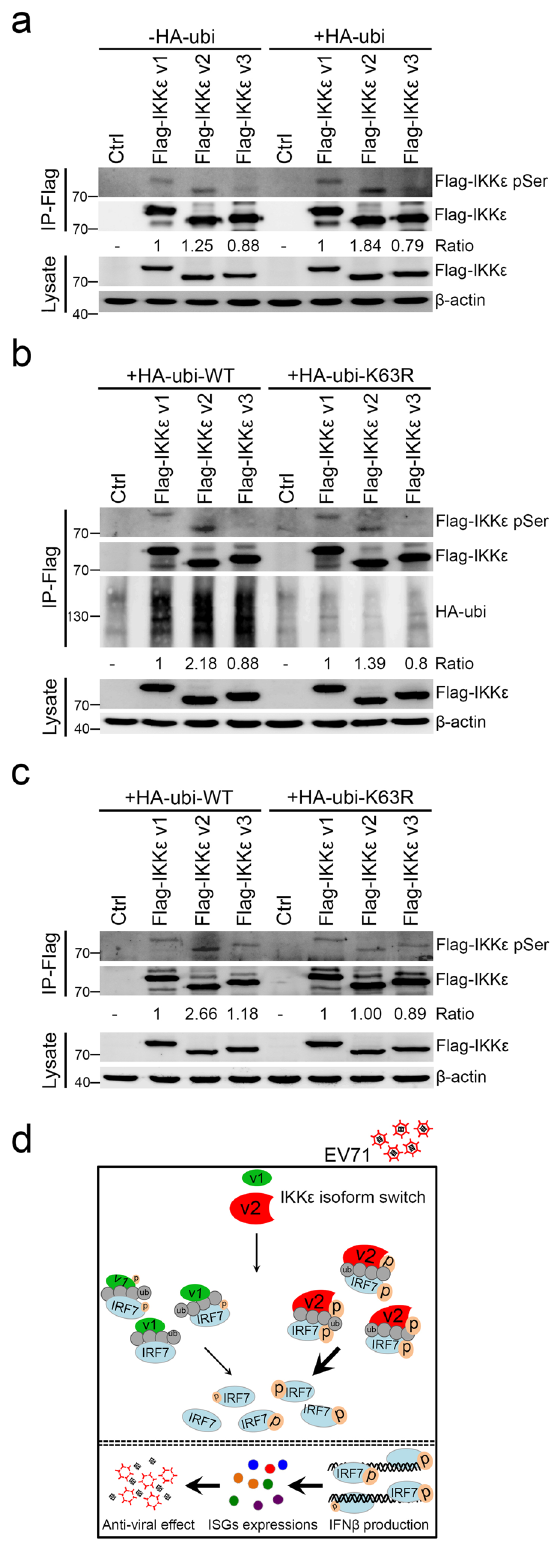
Fig. 5 IKK ε v2 processes high phosphorylation status through K63-linked ubiquitination. a IKK ε v2 presents higher phosphorylation status. HEK293 cells were transfected with each Flag-IKK ε isoform accompanied with or without HA-ubi. Immunoprecipitation was performed with anti-Flag beads and the resulting products were detected by anti-phospho-Serine (pSer) and anti-Flag antibodies. b , c K63R ubiquitin markedly reduces IKK ε v2 phosphorylation. HEK293 cells were transfected with each Flag-IKK ε isoform accompanied with wild-type or K63R HA-ubi. Immunoprecipitation was performed with anti-Flag beads and the resulting products were further assayed by immunoblot with anti-phospho-Serine, anti-Flag, and anti-HA antibodies ( b ) and in vitro kinase assay ( c ). β -actin was served as an internal control. d Molecular mechanism of IKK ε isoform switching in EV71